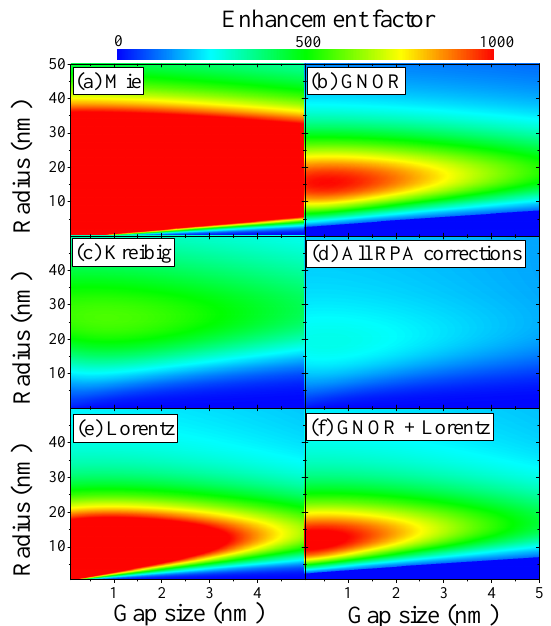
Figure 6. Impact of microscopic electron dynamics on gold dimers in water. We show the maximum field enhancement at the gap center of gold dimers dispersed in water in dependence of their radius ( a > 0.5 nm) and separation (>0.1 nm) for ( a ) classical Mie calculations, ( b ) spatial dispersion with GNOR, ( c ) Kreibig damping, ( d ) all RPA corrections combined, ( e ) Lorentz friction and ( f ) GNOR with Lorentz friction. The incident field is polarized along the dimer axis and the maximum EF is evaluated at the respective resonance frequency calculated for each